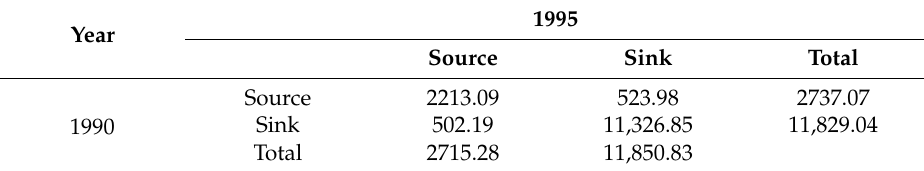
Table 24. The source-sink landscape transition matrix from 1990 to 1995 (km 2 ).